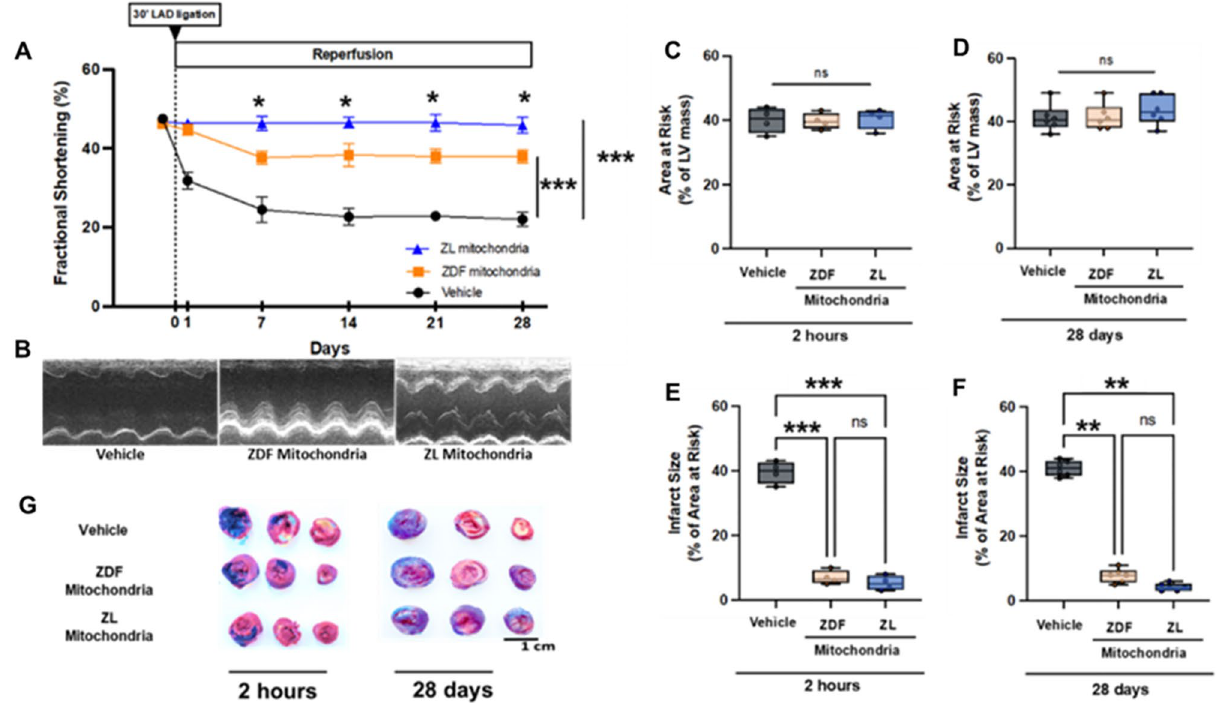
Figure 4. Myocardial function and viability. Left ventricular fractional shortening ( A ), determined by echocardiography in Vehicle hearts and in hearts receiving diabetic ZDF- or non-diabetic ZL-mitochondria at day 0 (baseline) and at 1, 7,14, 21 and 28 days recovery. Representative M mode at 28 days recovery is provided (B) . Area at risk as percentage of left ventricular mass in Vehicle hearts and in hearts receiving diabetic ZDF- or non-diabetic ZL -mitochondria following 30 min regional ischemia at 2 h ( C ) and 28 days recovery ( D ). Infarct size as % of area at risk in Vehicle hearts and in hearts receiving diabetic ZDF- or non-diabetic ZL -mitochondria following 30 min regional ischemia at 2 h ( E ) and 28 days recovery ( F ). Representative images of ZDF rat hearts stained with 1% triphenyltetrazolium chloride (TTC) for hearts receiving vehicle alone, diabetic ZDF- or non-diabetic ZL -mitochondria, following 30 min regional ischemia and at 2 h and 28 days recovery ( G ). White areas show myocardial necrosis. Brick red areas show viable tissue. Scale in cm is shown. All results are shown as the mean plus and minus the standard error of the mean for n = 6 for each group. Statistical differences are shown as * p < 0.05, ** p < 0.01, *** p < 0.001; ns: not